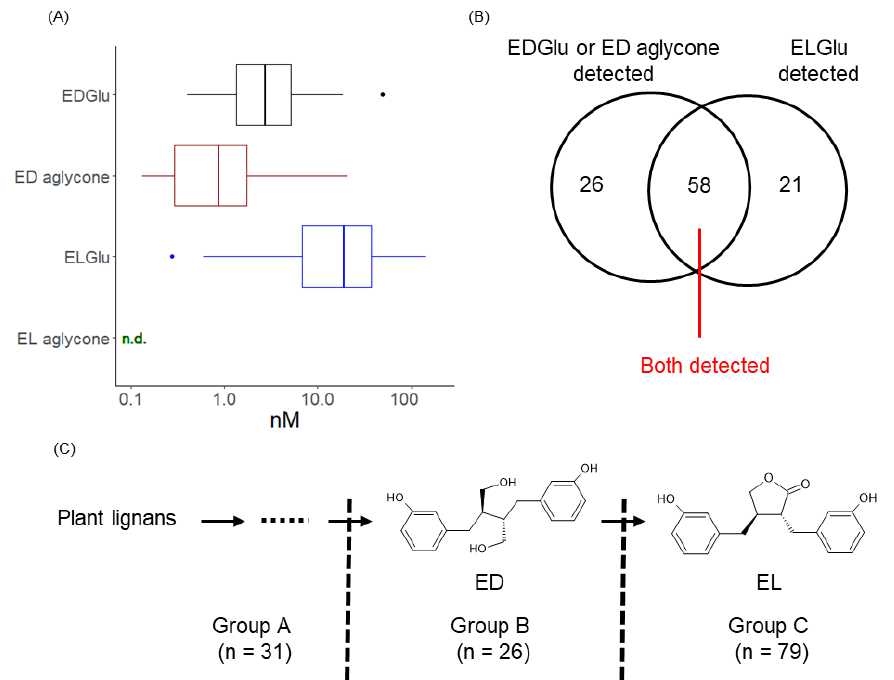
Figure 1. Detection of enterolignans in human serum and evaluation of individual enterolignan metabolic profile in Main cohort. ( A ) Concentration of EDGlu, ED, ELGlu, and EL in human serum. In the box plots, the boundary of the box closest and farthest to zero indicates the 25th and 75th percentile, respectively, and a line within the box marks the median. Whiskers indicate minimum and maximum values. Points above the whiskers indicate outliers. ( B ) Distribution of enterolignan metabolic profiles in Main cohort. ( C ) Discrimination of subjects in Main cohort based on individual enterolignan metabolic profile. Subjects were divided into Group A (who cannot produce either ED or EL), Group B (who can produce ED but not EL), and Group C (who can produce EL, including people who can produce ED also).